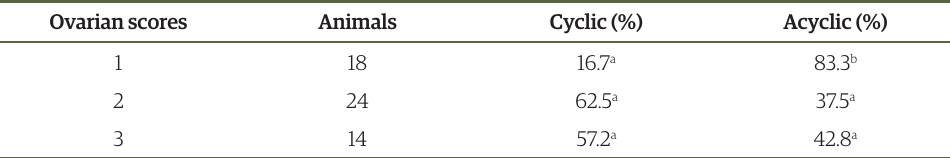
Table 2. Percentage of cyclic and acyclic heifers at the beginning of the Timed Artificial Insemination protocol according to the ovarian score.